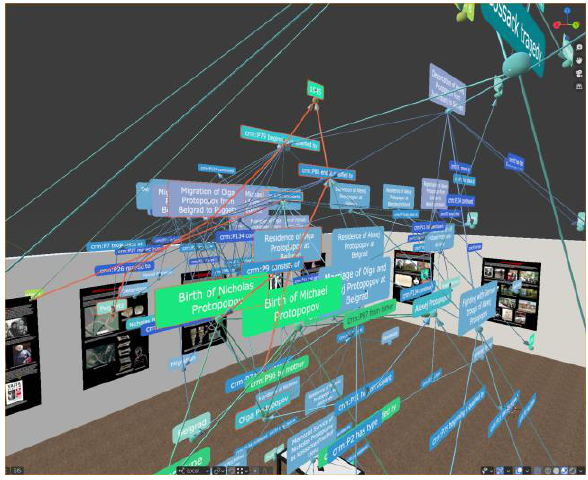
Figure 8. Sparql-query with “SPARQLing Unicorn”-Plugin for QGIS and visualization of the movements of Olga Protopopov with her children and Alexej Protopopov (Basemap: ©ESRI Topographic